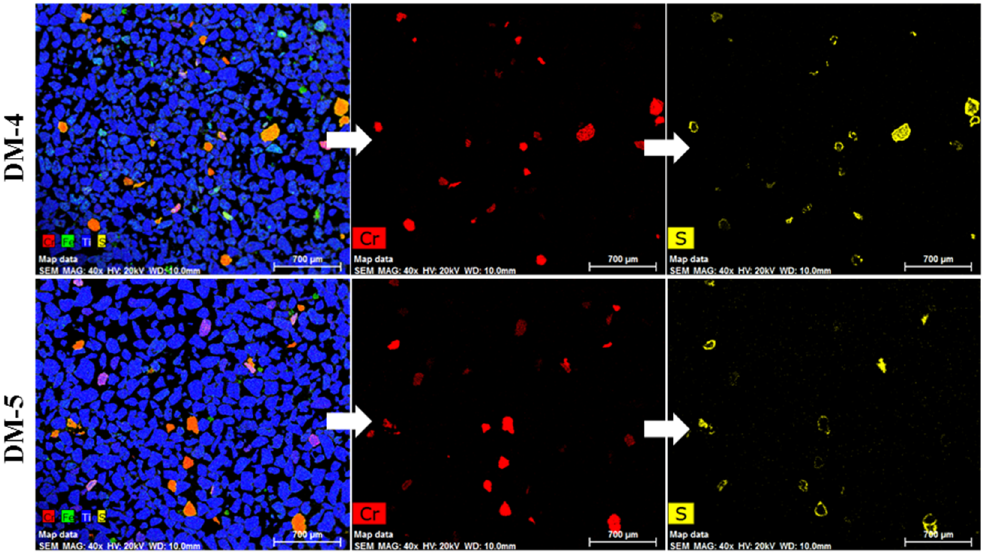
Figure 18. EDX mapping of samples DM‒4 (magnetic) and DM‒5 (non-magnetic) obtained after magnetic separation of sample DM‒2 at 0.3 A.